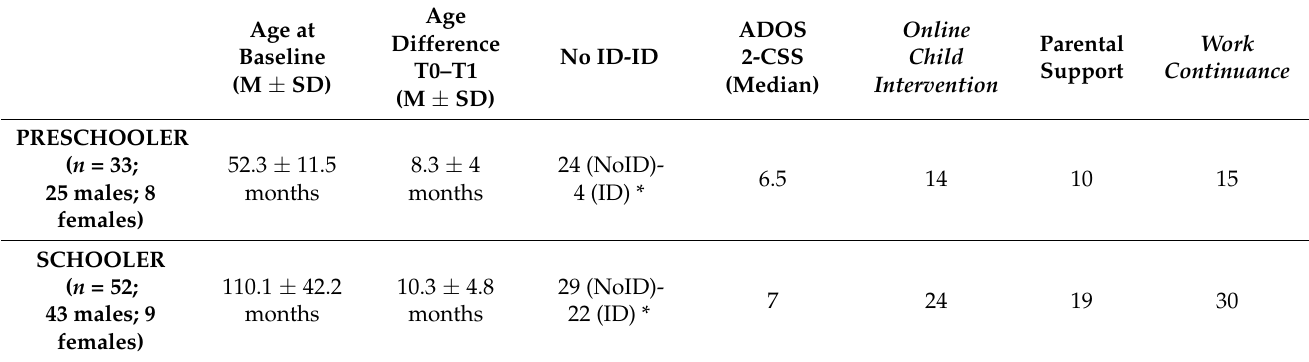
Table 1. Main characteristics of the age